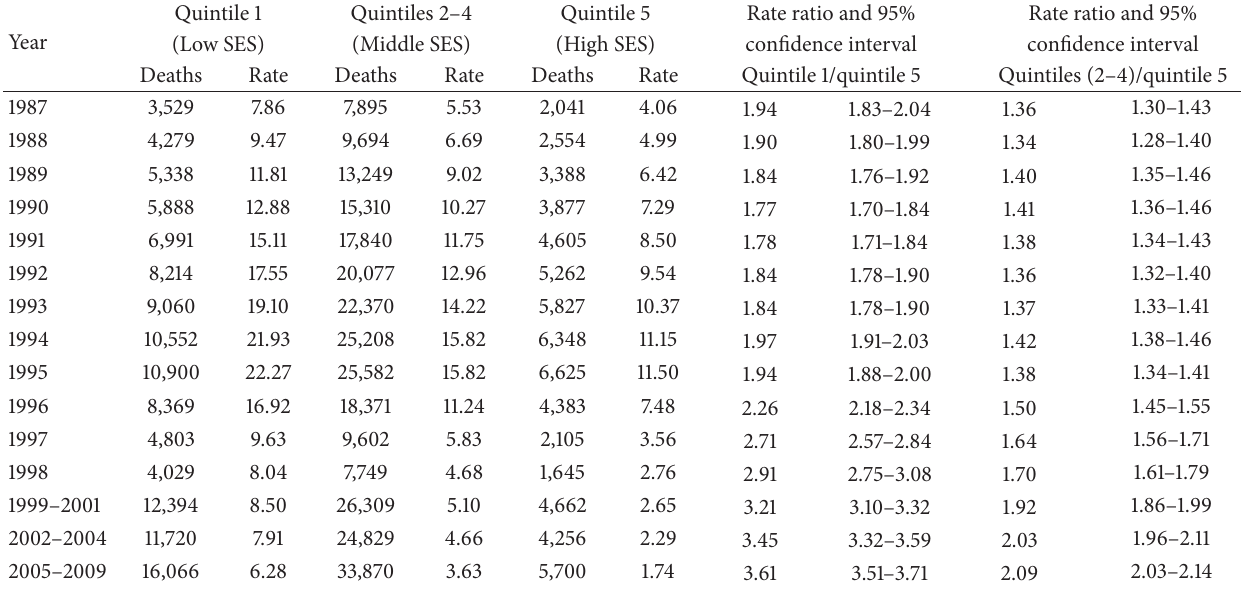
Table 1: Trends in age-adjusted HIV/AIDS mortality rate per 100,000 population according to socioeconomic deprivation quintiles, United States, 1987–2009.